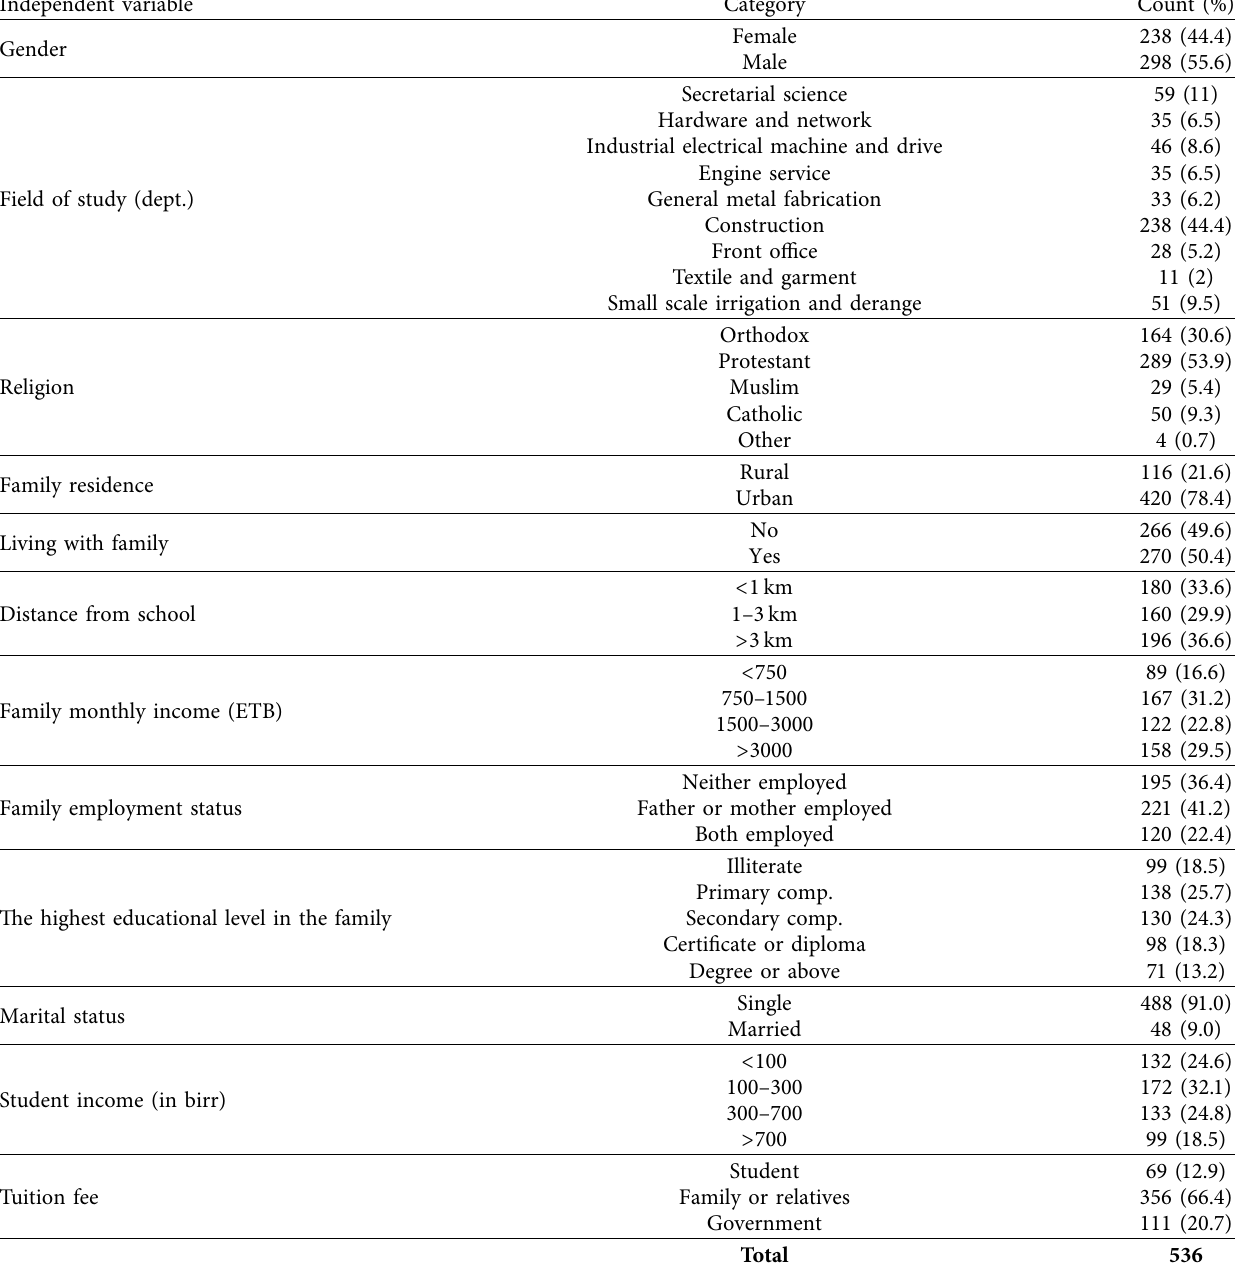
Table 1: Frequency distribution of sociodemographic variables.